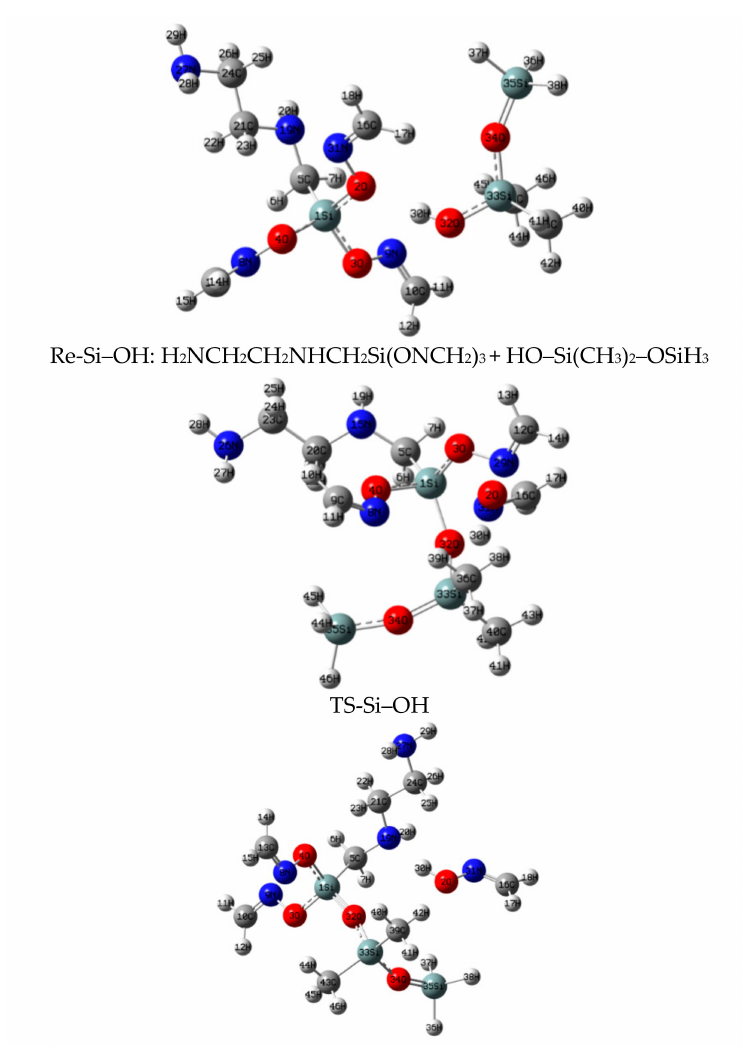
Figure 4. Geometries of stationary points of the reaction between α -EAMOS and HO–Si(CH 3 ) 2 –OSiH 3 at the B3LYP/6-311G**